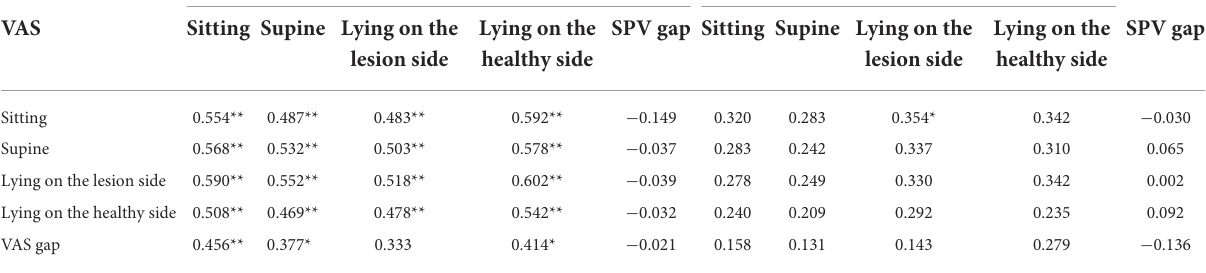
TABLE 1 Correlation analysis between the intensity of spontaneous nystagmus (maximal SPV) and vertigo severity (VAS) at each position.